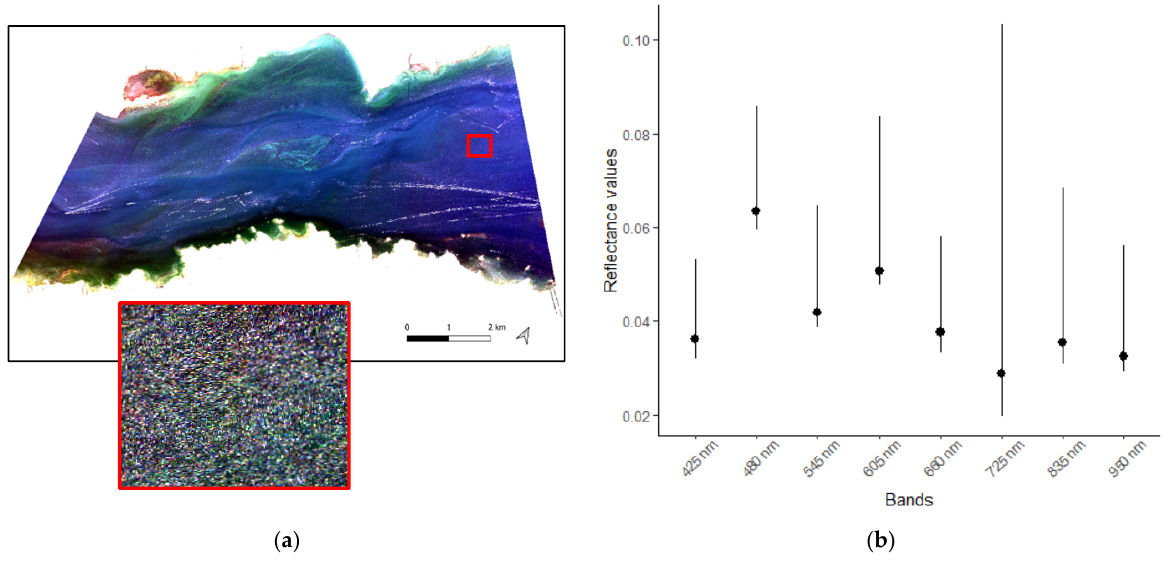
Figure 9. Value range for all bands in a deep-water area affected by surface waves. ( a ) Shows a seemingly homogenous area of deep water in the eastern part of lake St-François. ( b ) Shows minimum, mean (dot) and maximum pixel values at every wavelength within this area.